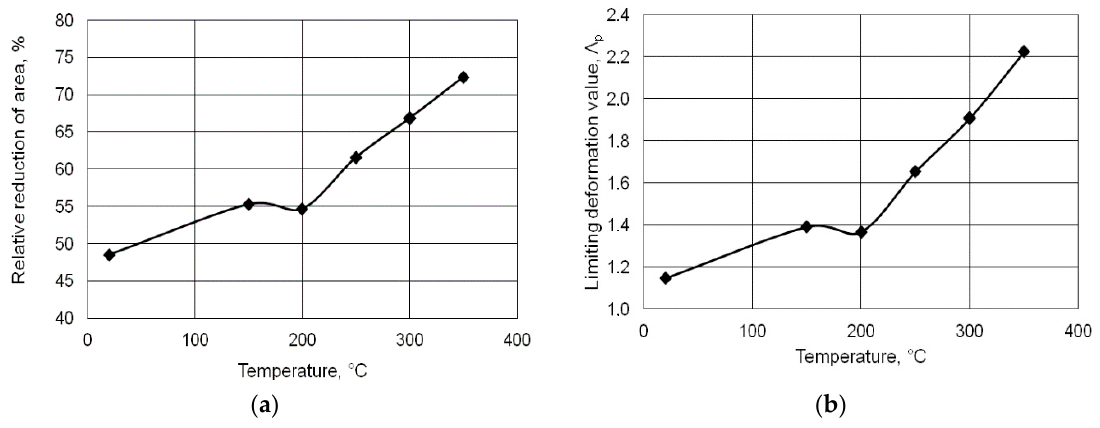
Figure 6. Relative reduction of area Z ( a ) and the limiting deformation value Λ p vs. temperature ( b ).